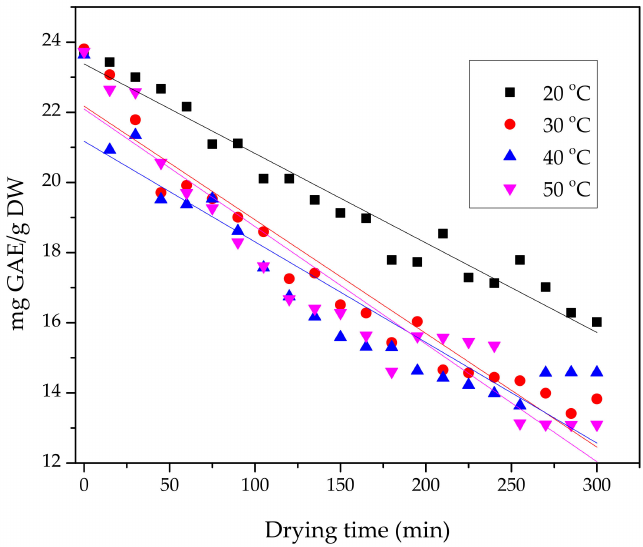
Figure 5. The zero–order kinetic model of polyphenols in the heat pump drying method.